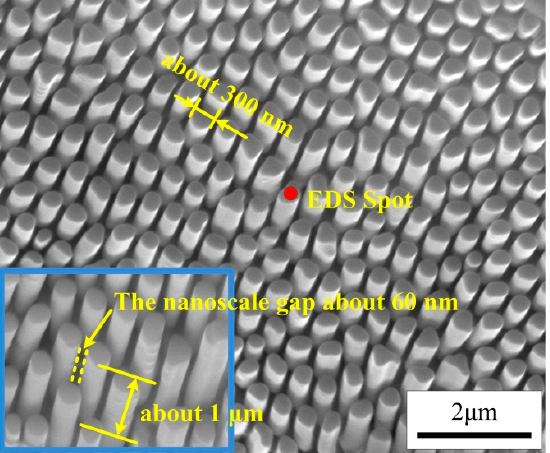
Figure 6. Morphology of the as-embossed nanostructure array with the characteristic size of 300 nm. Table 1. EDS results of the nanopillar surface.